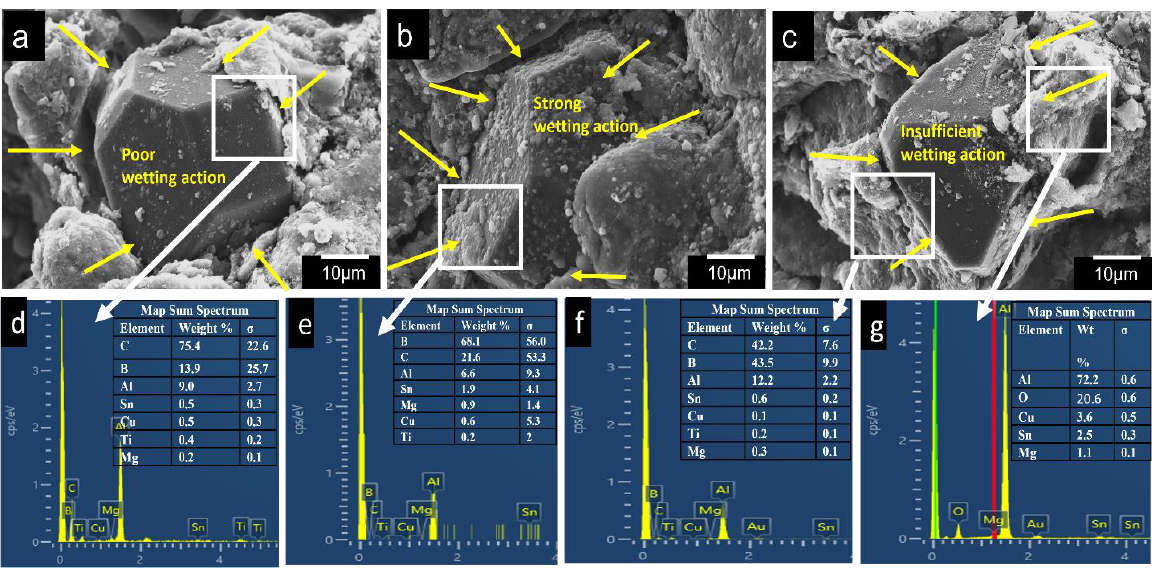
Figure 4. SEM images and EDX analysis of porous Al composites showing wetting action near the vicinity of diamond particles at different sintering temperatures, ( a , d ) 580 °C, ( b , e ) 590 °C, and ( c , f , g ) 600 °C.